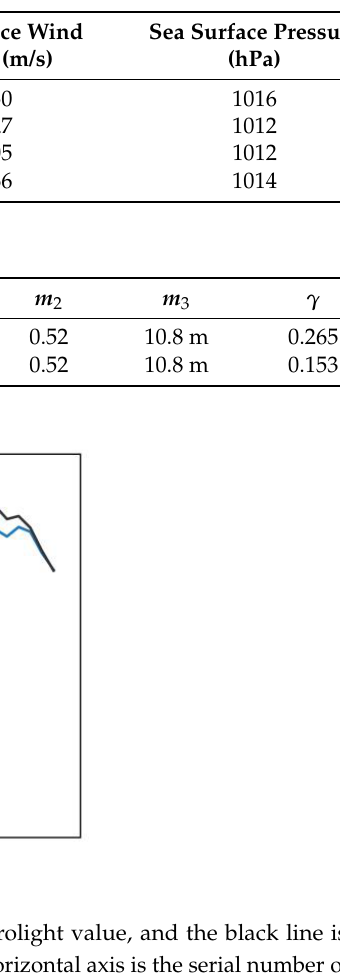
Table 7. Physical parameters of Wuzhizhou Island selected for Hydrolight simulations of water depth off Wuzhizhou Island.